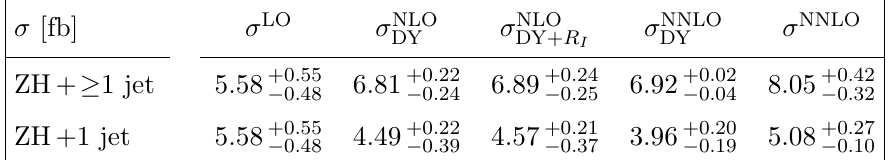
Table 3. The fiducial cross sections for inclusive ( ≥ 1 jet) (top line) and exclusive (1 jet) (bottom line) associated to ZH + jet process according to the setup of section 3 and the cross section expressions and labelings at (N)NLO levels as defined in section 2.3. The theory error on the values represents the minimum and maximum from the 7-point scale variation. See main text for